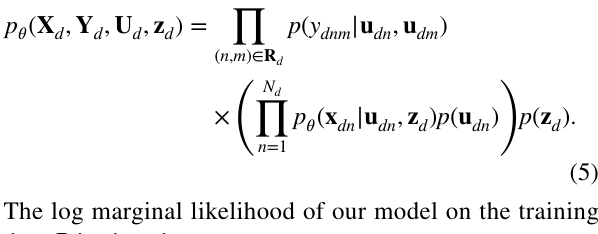
Fig. 2 Graphical model representation of the generative model and inference model of the proposed method. Here, 𝐱 d ⋅ , y d ⋅⋅ , 𝐮 d ⋅ , and 𝐳 d represent a feature vector, label, latent feature vector, and latent domain vector of d -th domain, respectively. Parameters for neural networks are represented by 𝜃 , 𝜙 z , and 𝜙 u . The shared and unshared